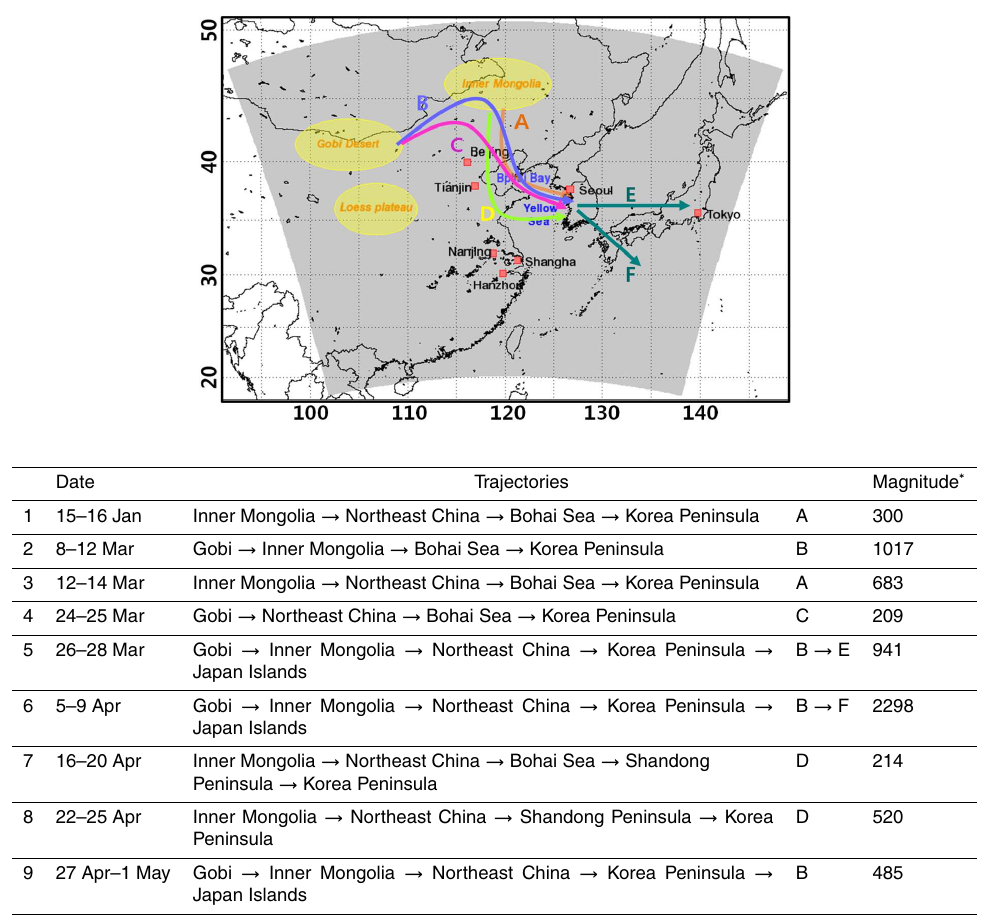
− 3 ) over Korean Peninsula for each event. 10 (µg/m ( µ g/m 3 ) over Korean Peninsula for each event. 10